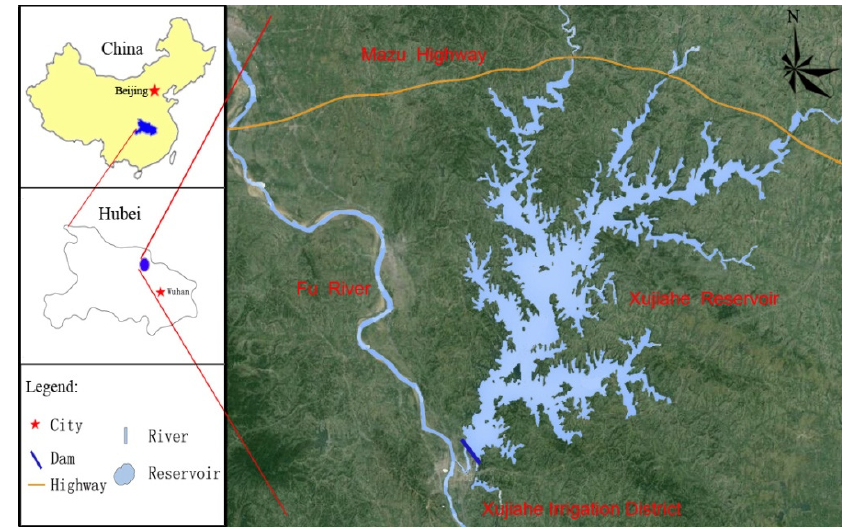
Figure 7. The location of the Xujiahe reservoir.